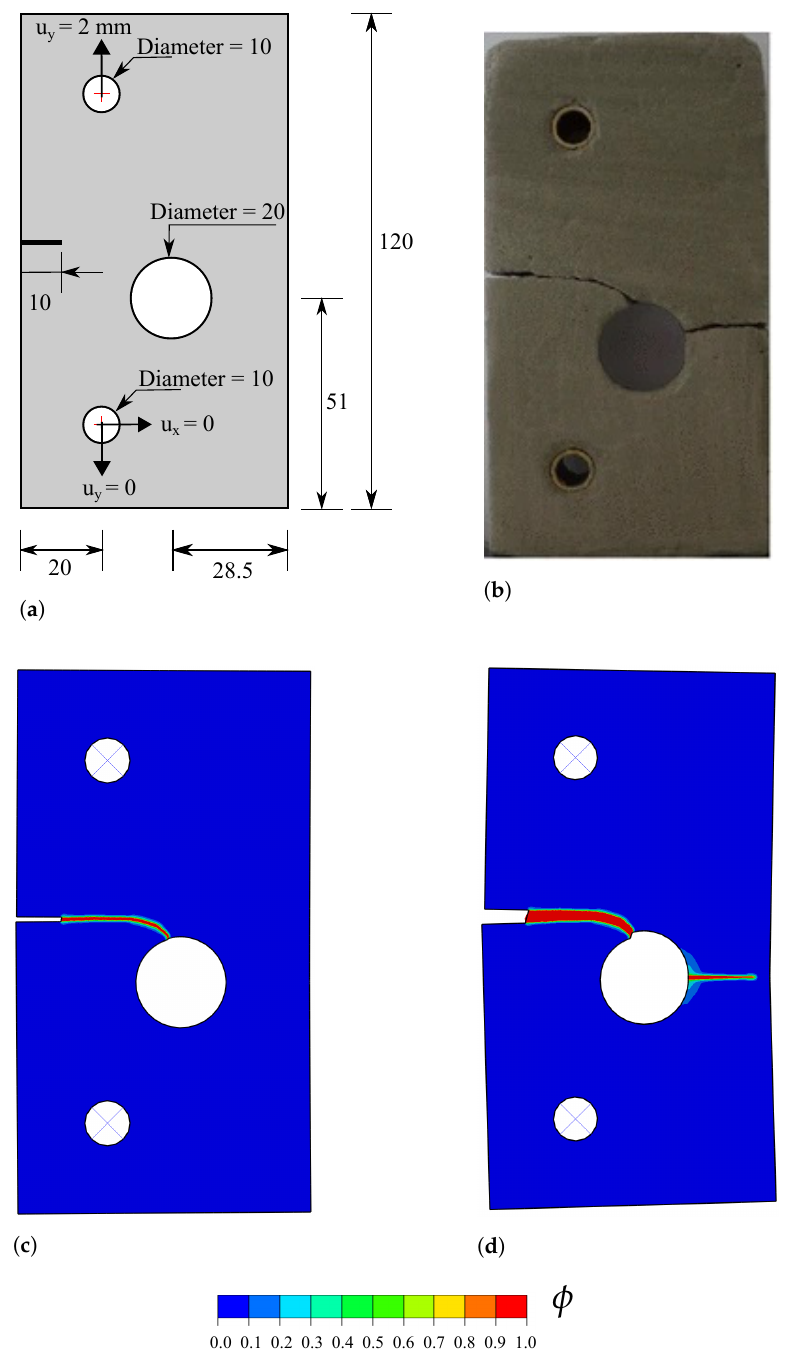
Figure 6. Notched plate with an eccentric hole: ( a ) geometry, dimensions (in mm) and boundary conditions, ( b ) experimental observation [44], and predicted phase field φ contours at ( c ) u = 0.4 mm and ( d ) u = 2